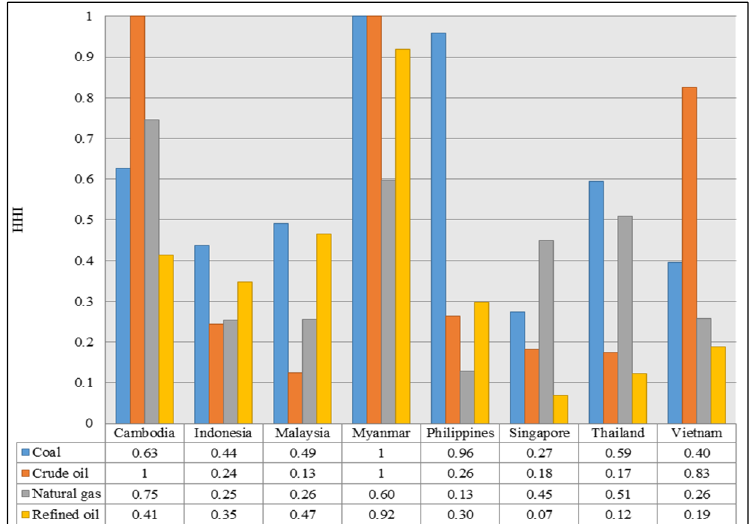
Figure 47. Market concentration of energy